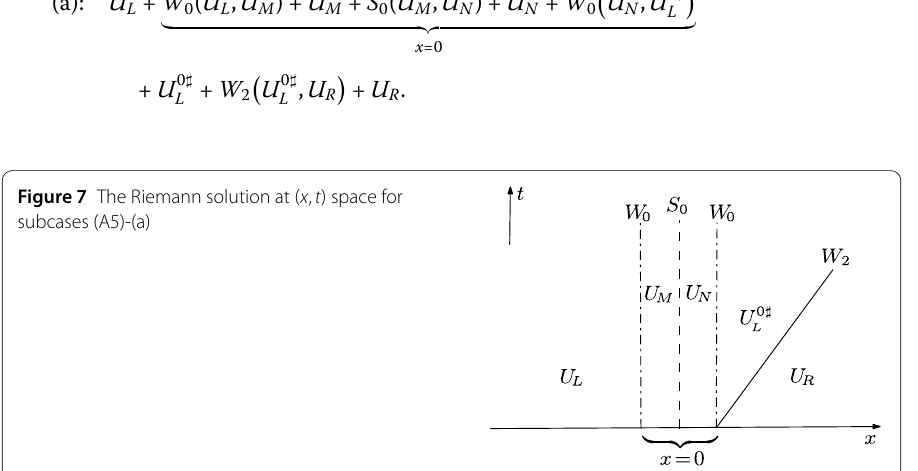
Figure 7 The Riemann solution at ( x , t ) space for subcases